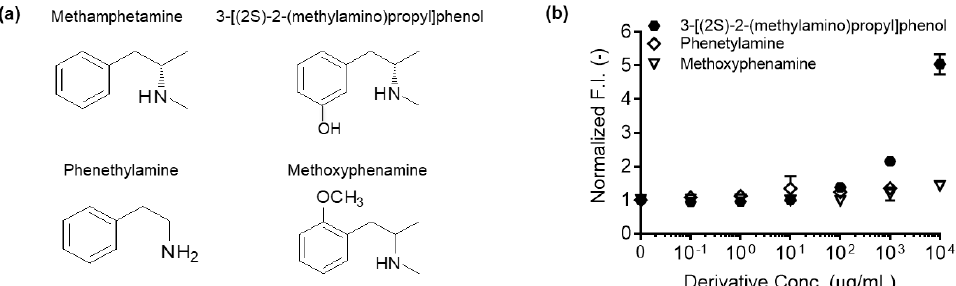
Figure 5. ( a ) Chemical structures of methamphetamine, 3-[(2S)-2-(methylamino)propyl]phenol, phenethylamine, and methoxyphenamine; ( b ) normalized fluorescence intensities of double TAMRA-C2-maleimide-labeled Q-bodies in the presence of 3-[(2S)-2-(methylamino)propyl]phenol, phenethylamine, or methoxyphenamine at the indicated concentrations. Methamphetamine itself was not used for generating the titration curve because illicit drug was not available for use in our laboratory. The normalized fluorescence intensity of each sample based on the fluorescence intensity at zero-dose was plotted. Error bars represent ± 1 SD (n = 3).